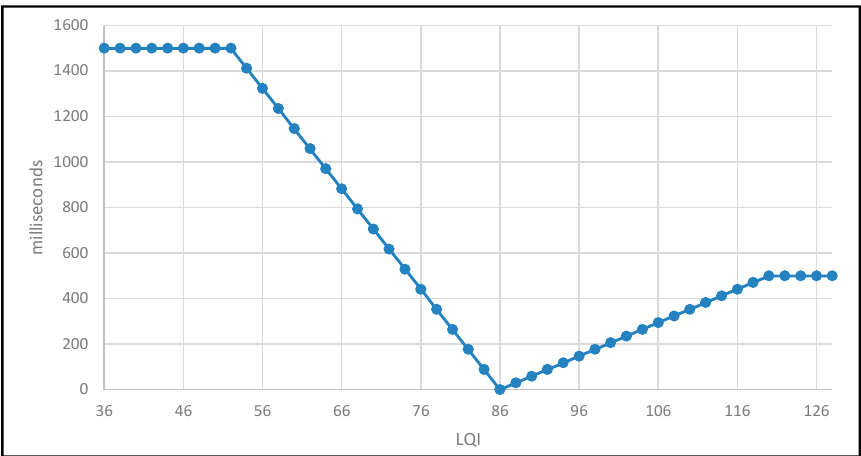
Figure 9. Representation of the jittering delay as a function of the LQI.